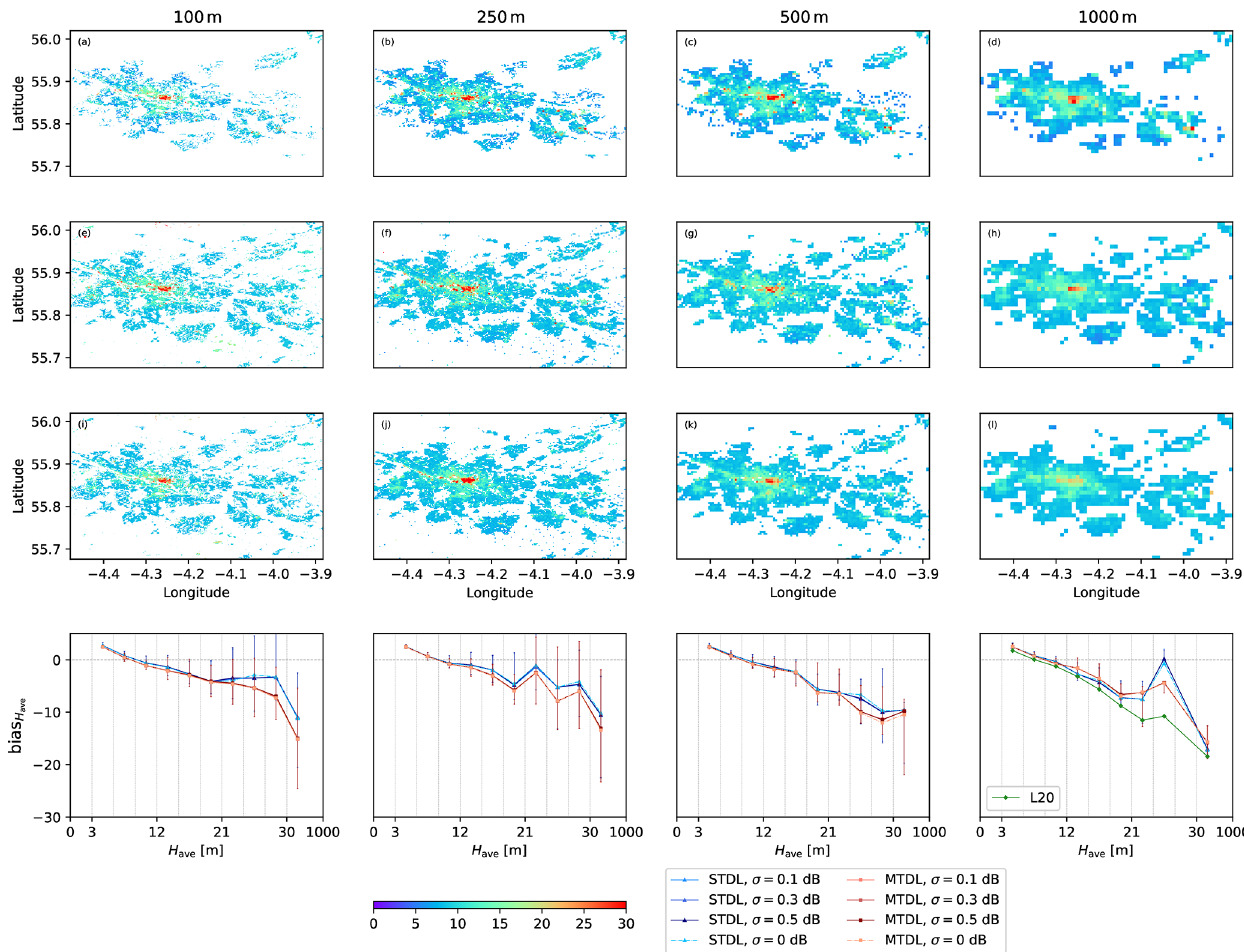
Figure 16. Building height prediction in Glasgow with corresponding stratified bias distribution. (a–d) Reference building height maps. (e– h) Building height maps predicted by STDL models. (i–l) Building height maps predicted by MTDL models. The bias is equal to prediction minus reference. σ is the standard deviation of Gaussian noises injected into the Sentinel-1’s VV and VH bands. σ = 0dB stands for